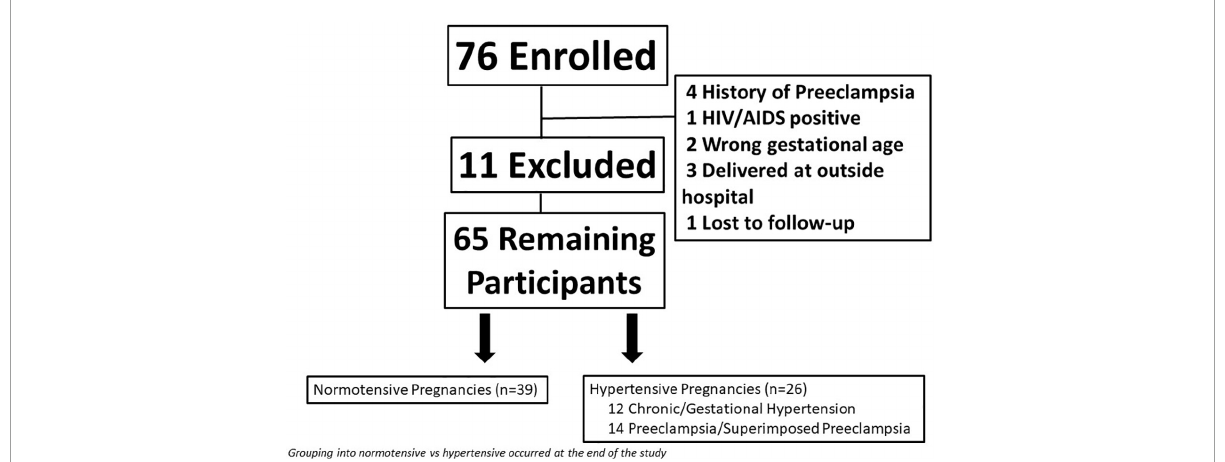
FIGURE1 Flow diagram of total study participants including women who were excluded from the study.